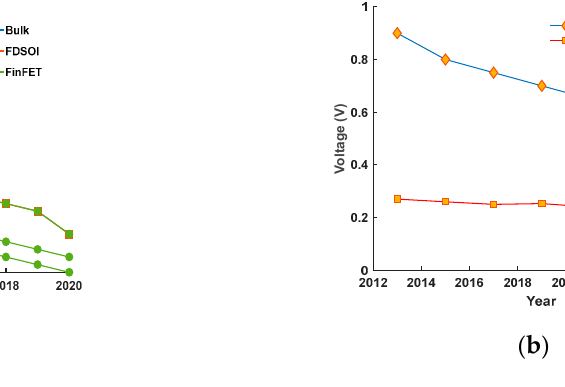
Figure 5. ( a ) Gate length evolution of application-specific circuit design for low standby power (LSTP), low operational power (LOP) and high performance (HP). ( b ) Supply voltage and threshold voltage scaling decreasing the noise margin headroom. (ITRS).